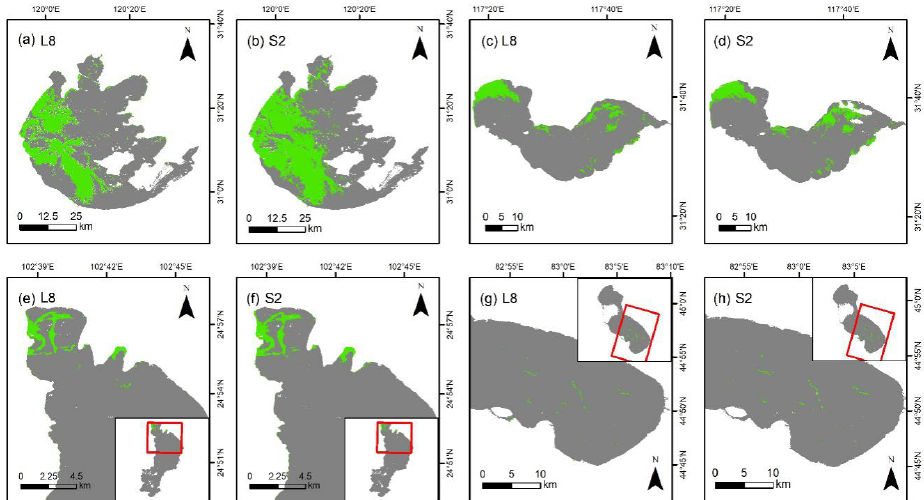
Figure 5. Area of lakes affected by floating algae: ( a , b ) floating algae at Lake Taihu, ( c , d ) floating algae at Lake Chaohu, ( e , f ) floating algae at Lake Dianchi, and ( g , h ) floating algae at Lake Ebinur. L-8 and S-2 refer to the data by the Landsat-8 OLI and the Sentinel-2 MSI, respectively.